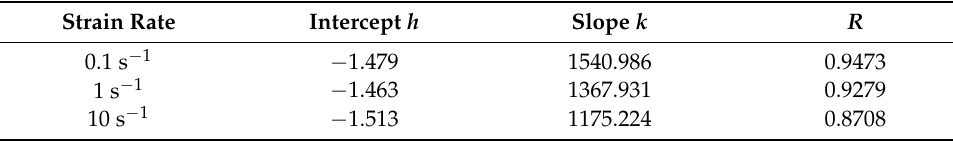
Table 5. Linear fitting results of Figure